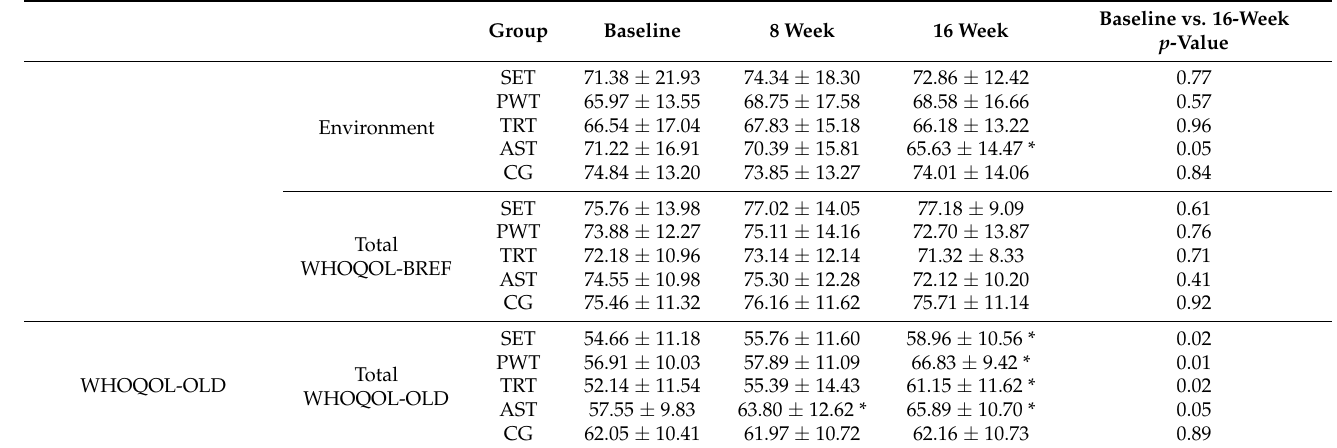
Table 3. Cont. Group Baseline 8 Week 16 Week